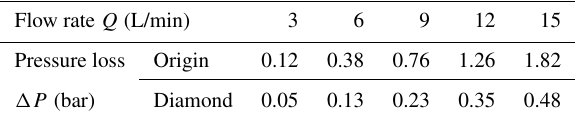
Table 5. Results of two